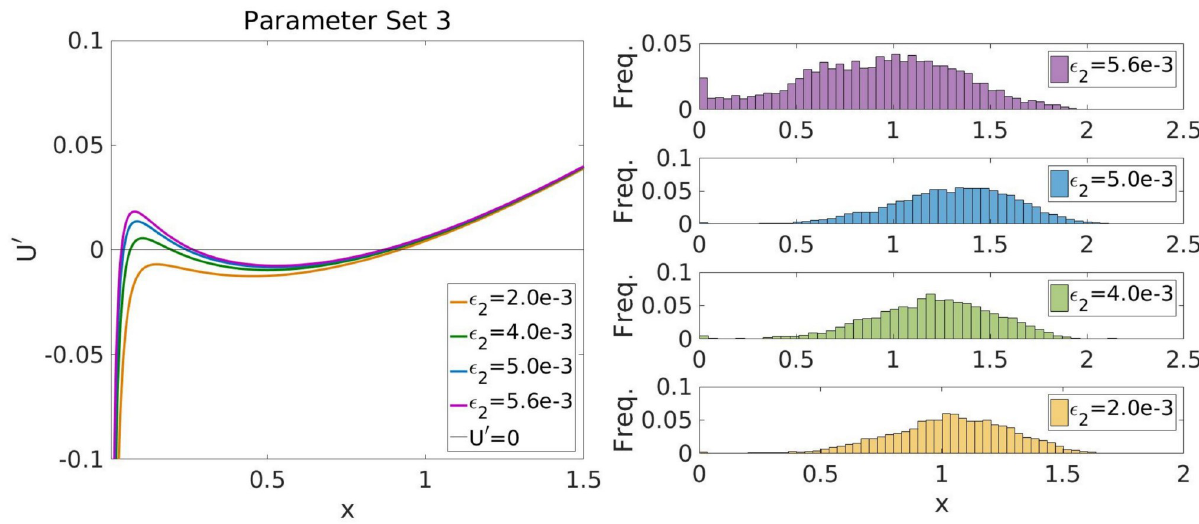
Fig 6. Noise-induced transition to bistable behaviour. This figure shows stochastic simulation results supporting the analytical prediction that our system exhibits a noise-induced transition form mono- to bi-stable behaviour. The plot shows how, as O decreases (i.e. the level of noise increases), the PDF of the system undergoes a transition from mono- to